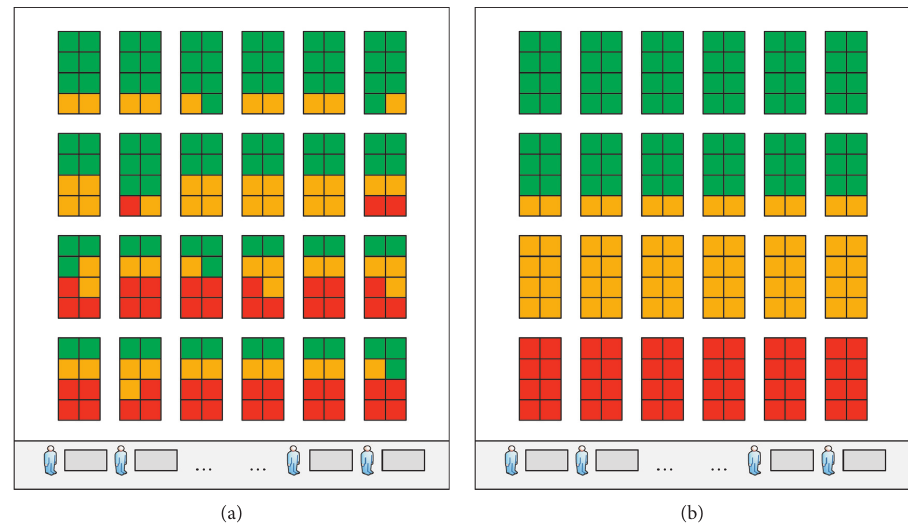
Figure 3: Comparison of workload balance using different pods assignment methods: (a) pods assignment using the proposed method and (b) pods assignment using ABC classification